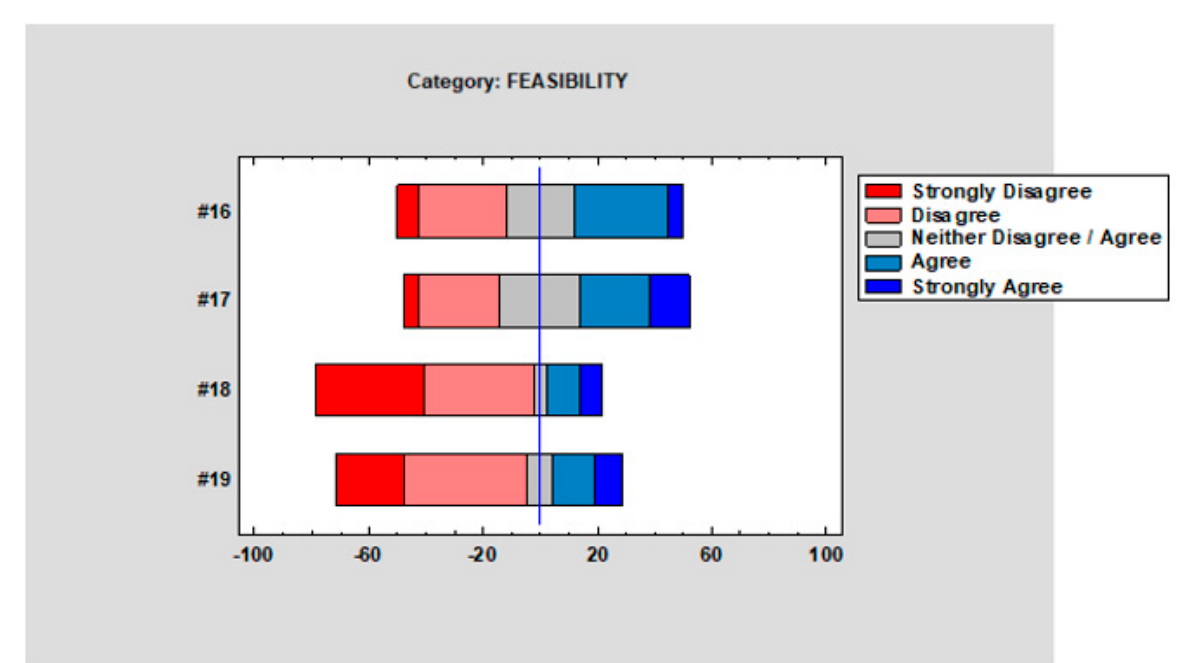
Figure 4. Likert Bar Graph representing scaled Feasibility Category question responses.